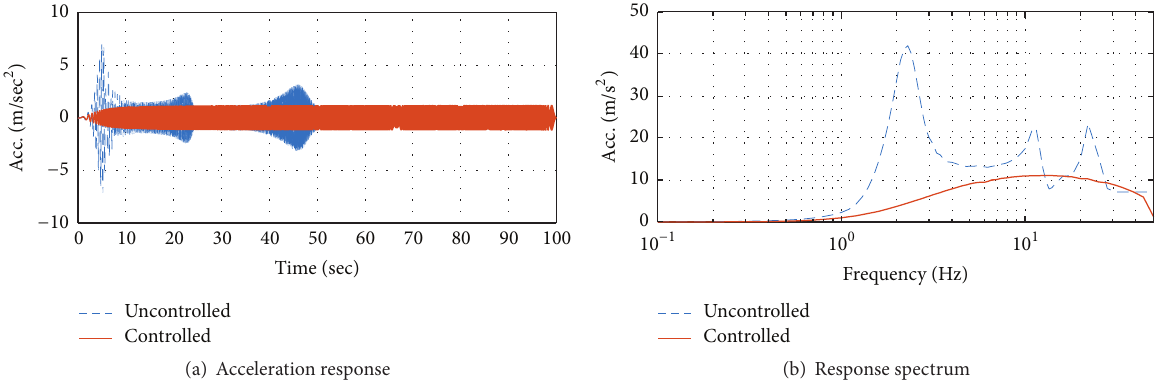
Figure 12: Response of piping system subjected to sine sweep wave ( 𝑧 -direction load and